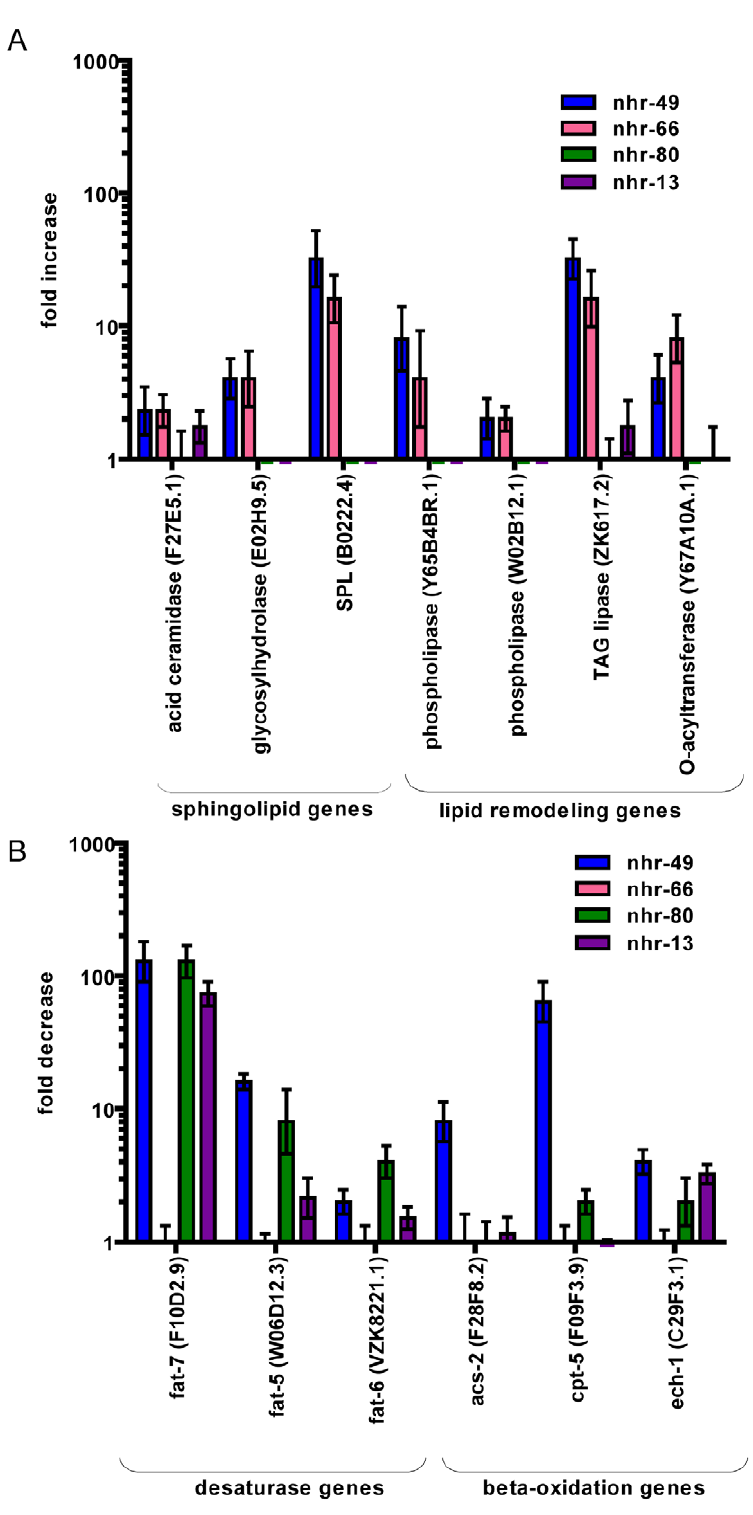
Figure 1. NHR-49 collaborates with NHR-66 to regulate sphingolipid and lipid remodeling genes and with NHR-80 and NHR-13 to regulate fatty acid desaturase genes. (A) qRT-PCR measurement of genes involved in sphingolipid metabolism including fatty acid ceramidase, sphingosine phosphate lyase, glycosyl hydrolase and genes involved in lipid remodeling namely phospholipases, TAG lipase and O-acyltransferease expression in nhr-49(nr2041) (blue bars), nhr-66(ok940) (pink bars), nhr-80(tm1011) (green bars) and nhr-13(gk796) (purple bars) relative to wild-type animals. Values represent overall fold change of nhr-49(nr2041) , nhr-66(ok940) , nhr-80(tm1011) and nhr-13(gk796) animals with respect to wild-type worms. Expression was measured in L4 stage of development. Error bars represent SEM from 3 independent experiments. (B) qRT-PCR measurement of genes involved in fatty acid desaturases including fat-5 , fat-6 and fat-7 and genes involved in fatty acid beta-oxidation including acs-2 , cpt-5 and